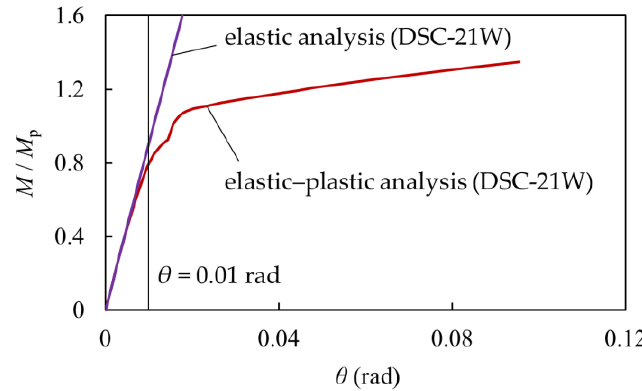
Figure 13. Comparison of the elastic and elastic – plastic analyses.